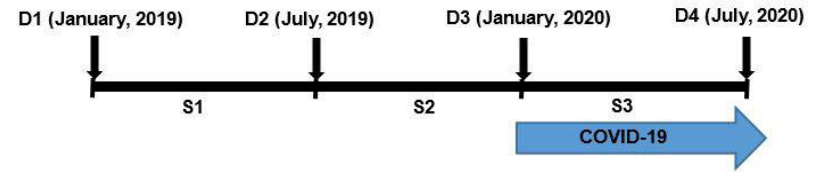
Figure 1. Schematic diagram of the dates of visits (D) and seasons (S).